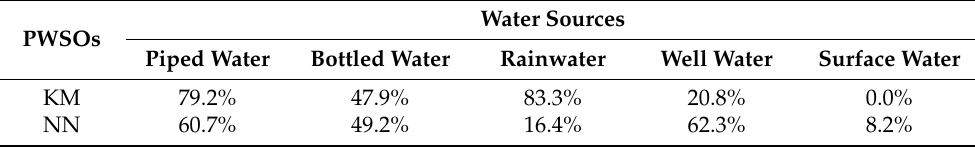
Table 4. Water sources of households in the KM and MM service areas (multiple choice).